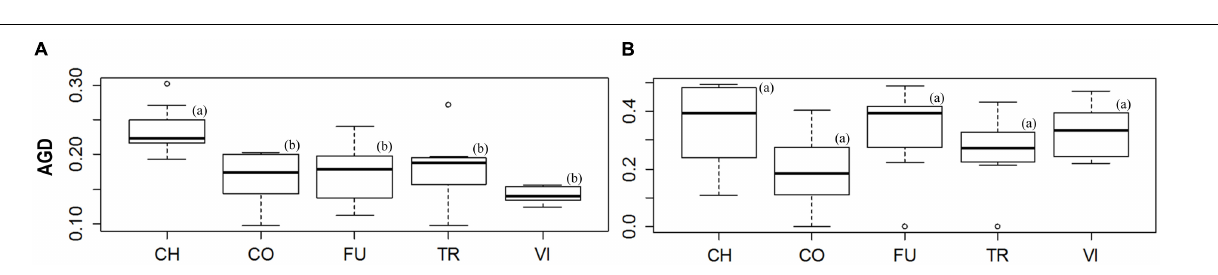
FIGURE 4 | Boxplot diagrams used to illustrate the differences across sites in the levels of average gene diversity over loci (AGD). Significant differences ( P -value < 0.05) between sites are highlighted by different letters in brackets. The diagrams (A,B) represent the differences of genetic diversity across sites for all and outlier loci, respectively.